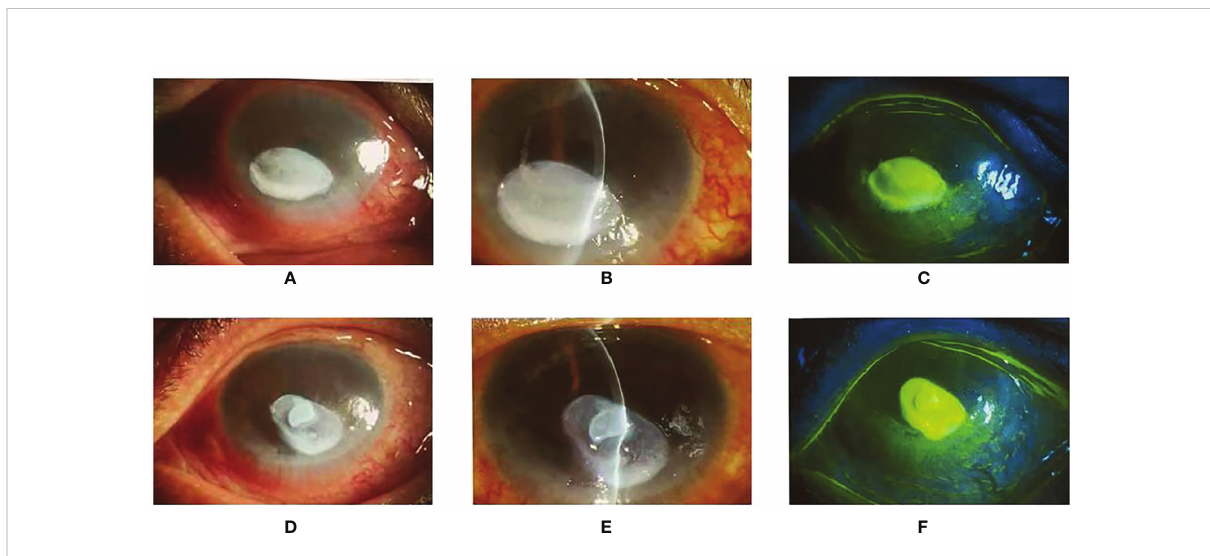
FIGURE 3 (A, B) : The right eye slit-lamp examination and anterior segment photography. There are mixed eyelid congestion and oval ulceration (3*5mm) in the central cornea. The opacity of the corneal lesions, edema around the lesions, and mild opacity of the other peripheral cornea can be observed. (D, E) : The left eye slit-lamp examination and anterior segment photography. The size of the ulceration is 3*6mm, other characteristics are the same as the right eye. (C, F) : Lamellar staining of the corneal epithelium in the ulceration of both eyes with fl uorescent, and punctate staining and positive seidel test were seen in the rest of the